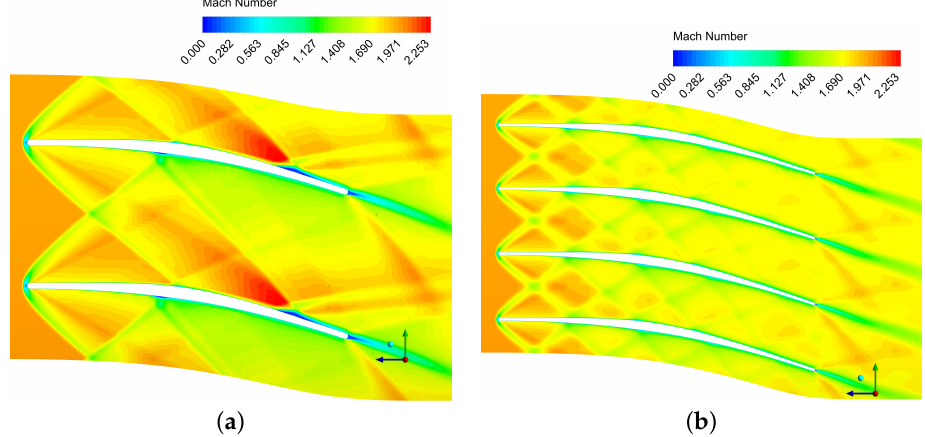
Figure 9. ( a ) Minimum solidity conditions assumed in this paper. ( b ) Maximum solidity as proposed by